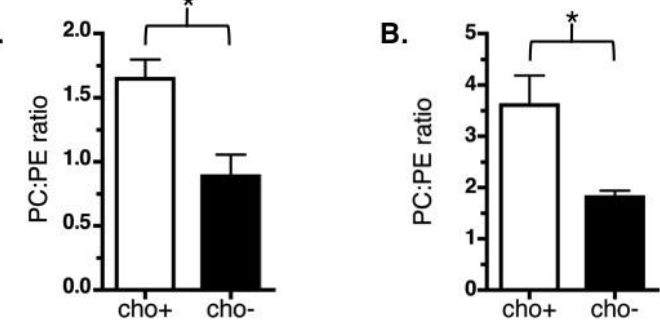
Figure 6. Choline deficiency significantly reduces the PC:PE ratio of LD phospholipid monolayers. NIH 3T3 ( A ) or AML12 ( B ) cells were grown with 500 μM oleate in control (cho+) or choline-deficient (cho − ) media for 48 h. LDs were isolated and phospholipids were extracted, then separated and identified by thin layer chromatography. Relative PC:PE levels are shown. Data are the average and SEM of four experiments (*, p < 0.03, unpaired t -test, two-tailed).